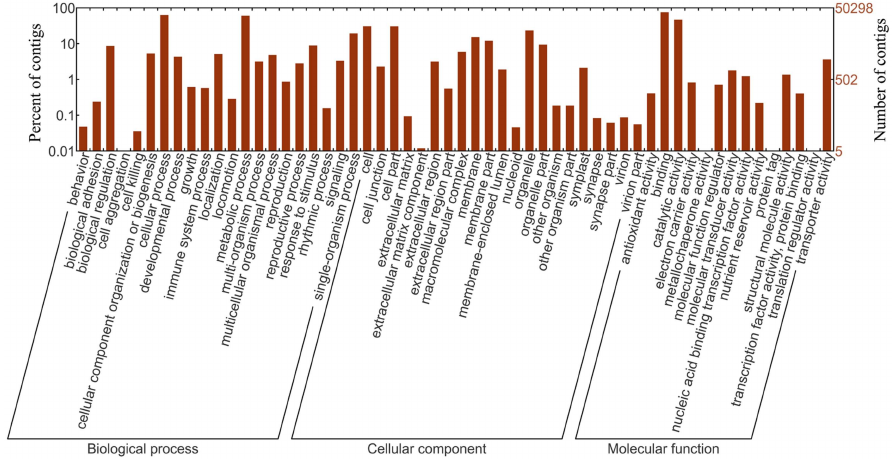
Figure 2. Gene ontology (GO) classification of T . koraiensis contigs.